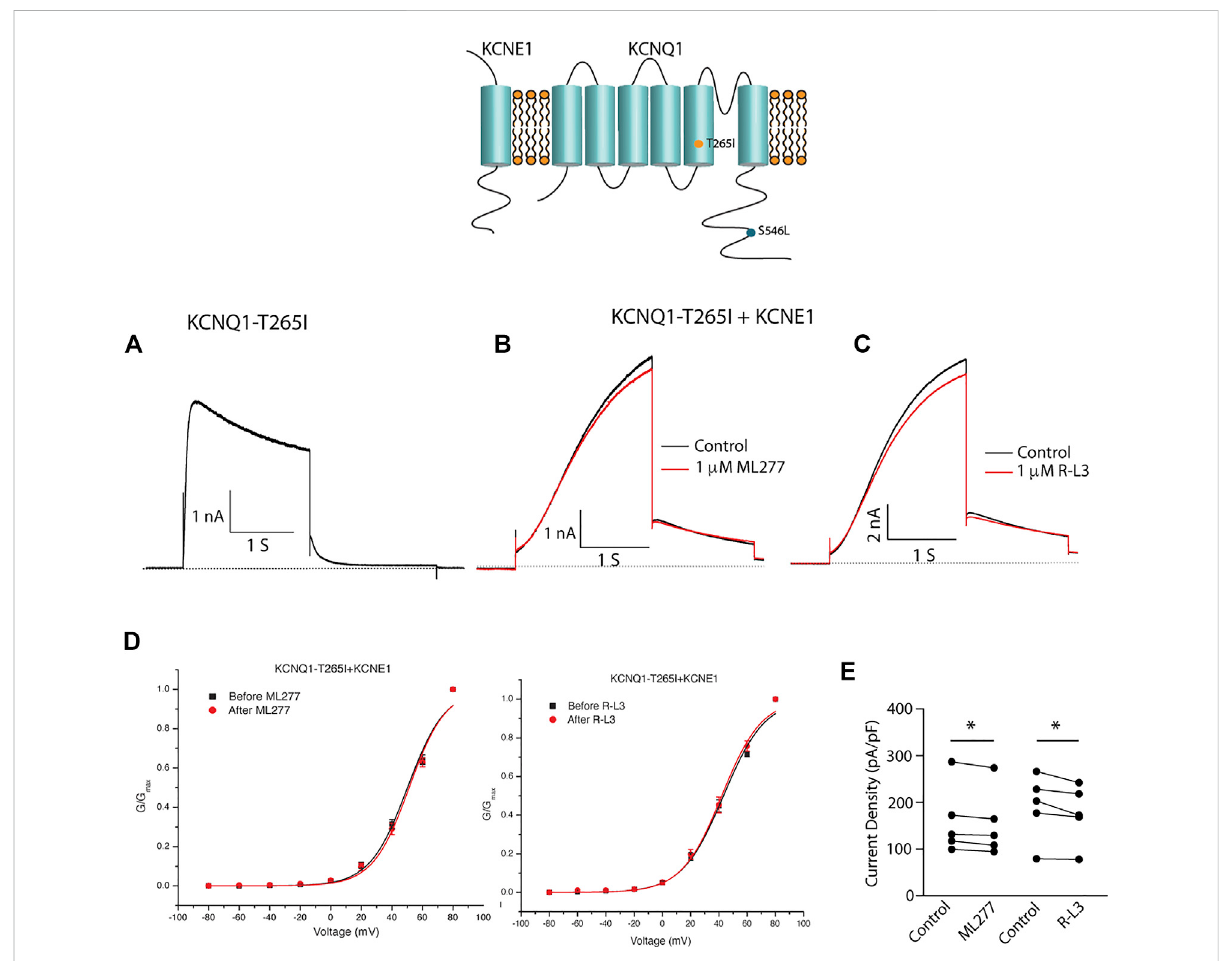
FIGURE 9 Select LQT-1 mutant channel currents are not augmented by ML277 and R-L3. (A) . Expression of KCNQ1-T265I without KCNE1 recorded at +60 mV. (B) . KCNQ1-T265I-KCNE1 channel activity at +60 mV in the absence (black trace) and presence (red trace) of 1 µM ML277. (C) . KCNQ1- T265I-KCNE1 channel activity at +60 mV in the absence (black trace) and presence (red trace) of 1 μ M R-L3. (D) . Normalized KCNQ1-T265I- KCNE1 channel conductance/voltage curves measured in the absence (black) and presence of 1 μ M ML277 (red curve, left panel) or RL-3 (red curve right panel). (E) . Summary data for peak current density measured after 2 s depolarization to +60 mV in the absence (control) and presence of 1 μ M of each drug with straight lines joining recordings for individual